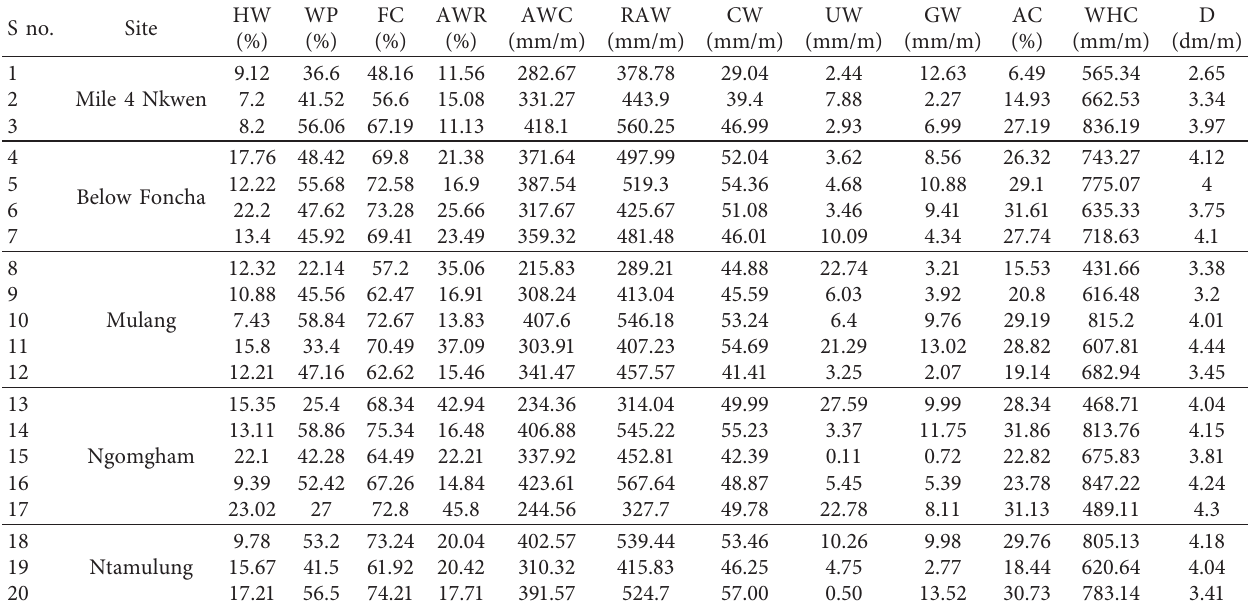
Table 3: Moisture characteristics of the Gleysols from the Bamenda Wetlands ( n � 20).